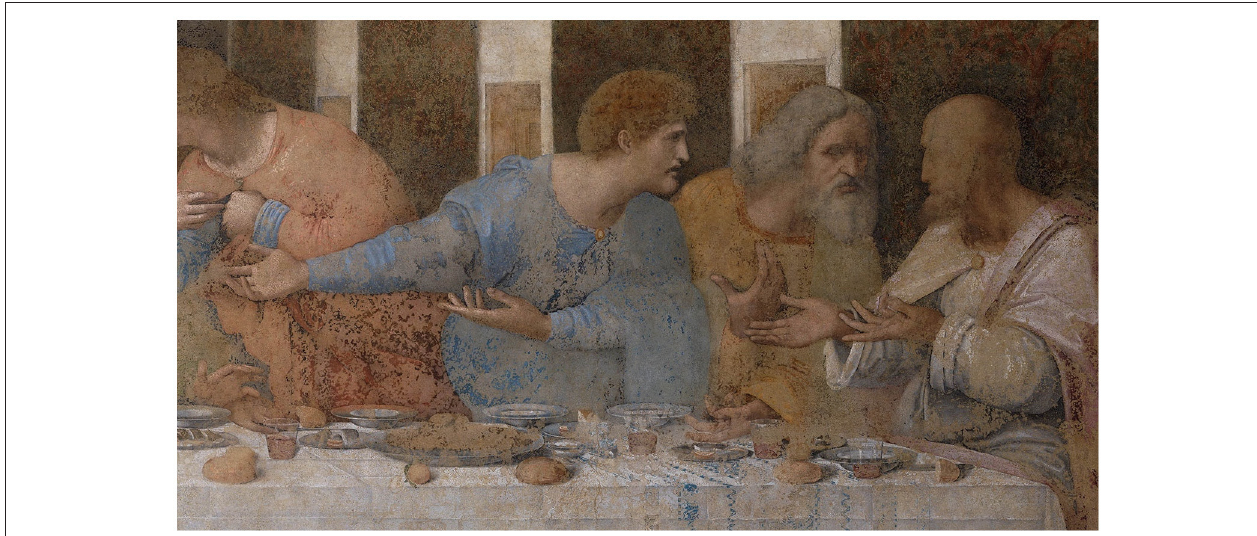
FIGURE 1 | Detail from Leonardo da Vinci’s The Last Supper , a mural from the late fifteenth century, showing three figures producing gestures with the palms turned